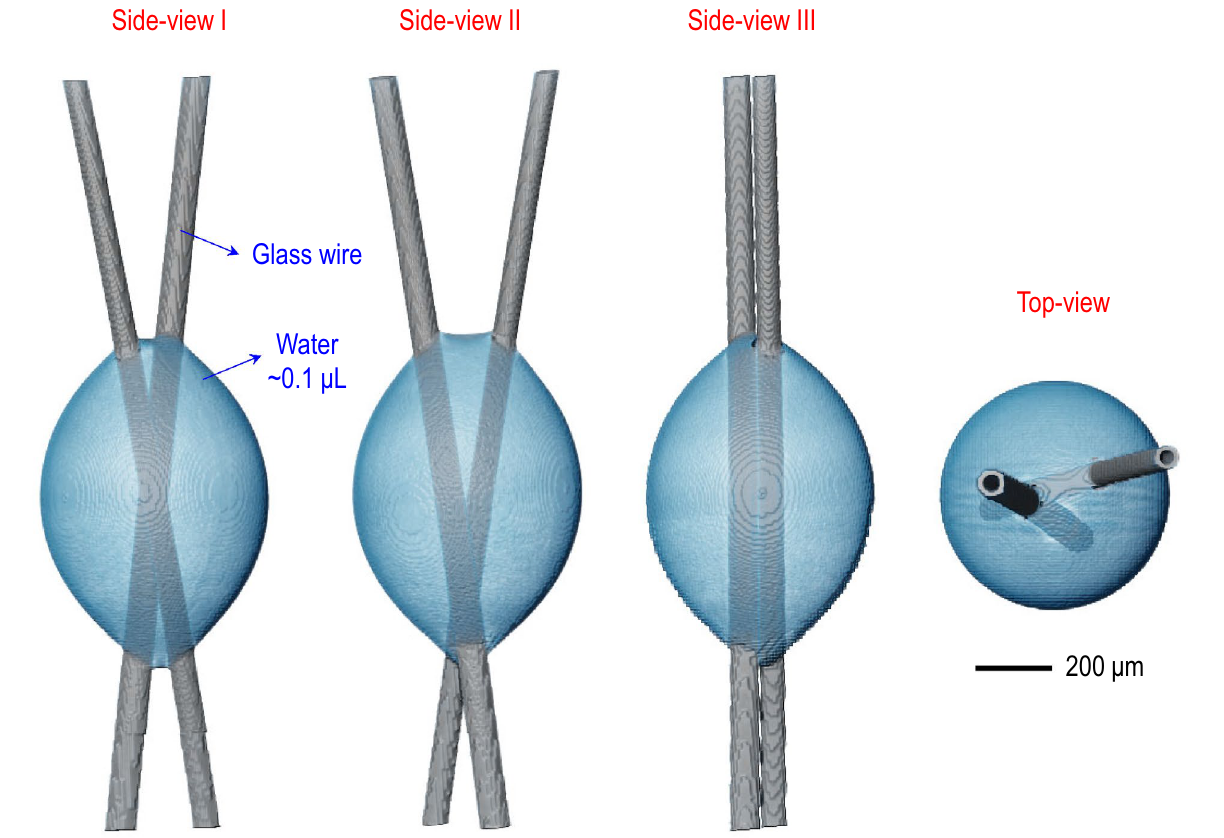
Figure 1. Topological heterogeneity of an irregular droplet. X-ray microtomography reveals the real shape of the initial 0.1 μL water droplet placed between two glass wires (where the crossing angle between wires is ◦ 22.07 ) at the initial time ( t = 0 ). The microtomographic images are demonstrated at different angles (side-view I, II, III, and top-view). Despite that the droplet should be spherical by the surface tension, not by the gravity (because the droplet size is much smaller than the capillary length for water ( ∼ 2.7 mm)), the droplet shape is deviated from the spherical cap, indicating the topological